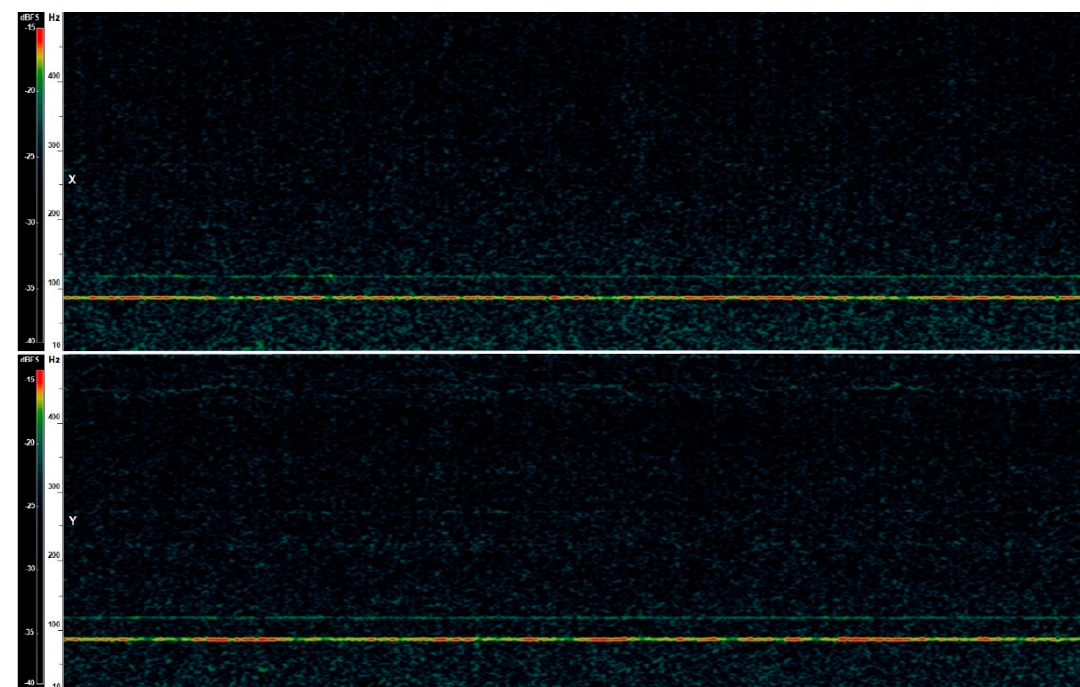
Figure 8. The spectrograms for printer vibration signals in standby mode.